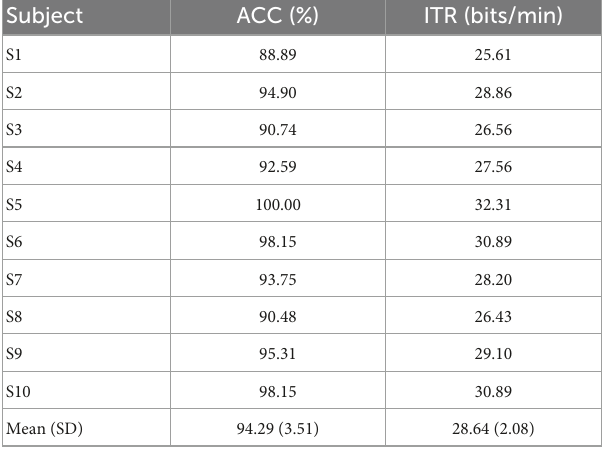
TABLE 1 Performance of the hybrid speller and its counterparts in the offline calibration tests.